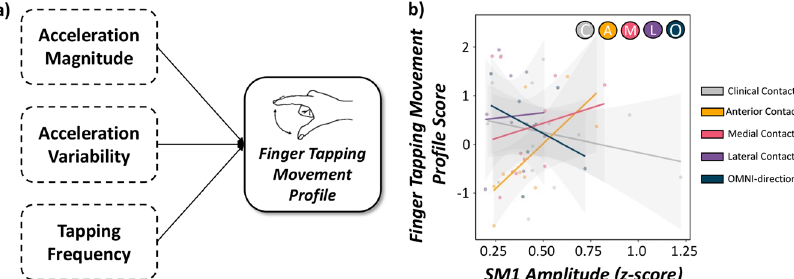
Fig. 3 Finger tapping movement pro fi les are predicted by SM1 evoked cortical responses in a contact-dependent manner. a Conceptual fi gure denoting the statistical model probed in the current study to derive data-driven accelerometer-based movement pro fi les of fi nger tapping. The factors contributing to fi nger tapping movement pro fi les were obtained from an EFA including acceleration magnitude, acceleration variability (i.e., coef fi cient of variation) and reverse-coded tapping frequency with lower values of fi nger tapping movement pro fi les re fl ective of smoother movements during fi nger tapping blocks. b LME of fi nger tapping movement pro fi les scores as a function of SM1 response amplitude (continuous variable), contact orientation (factor with 5 levels) and their interaction were conducted controlling for acquisition order and total electrical energy delivered. There was a signi fi cant SM1 response by contact orientation interaction such that when clinically-effective contact orientations were applied, larger SM1 response amplitudes were predictive of smoother fi nger tapping movement pro fi les. 95% con fi dence intervals are displayed in gray for each regression